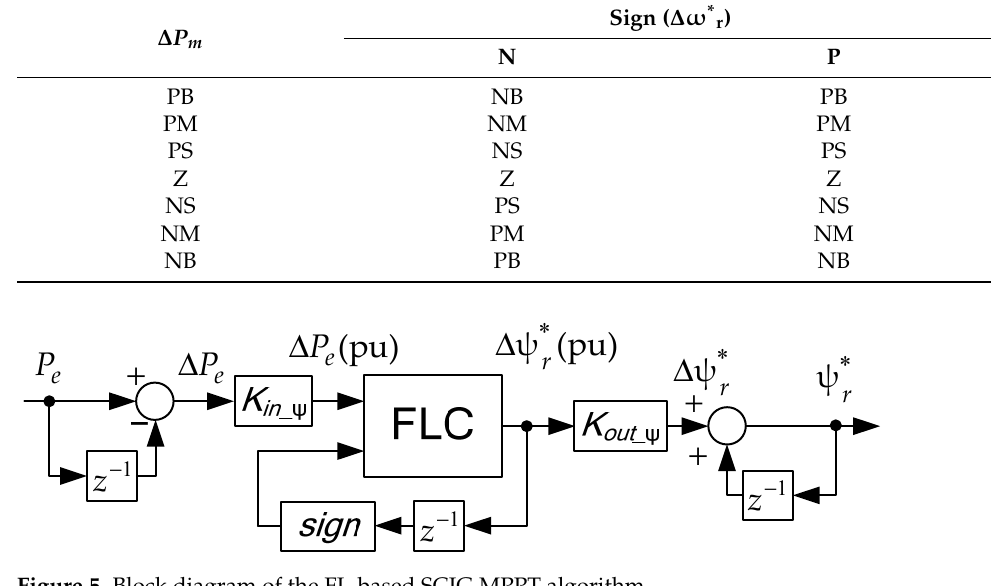
Figure 5. Block diagram of the FL-based SCIG MPPT algorithm.